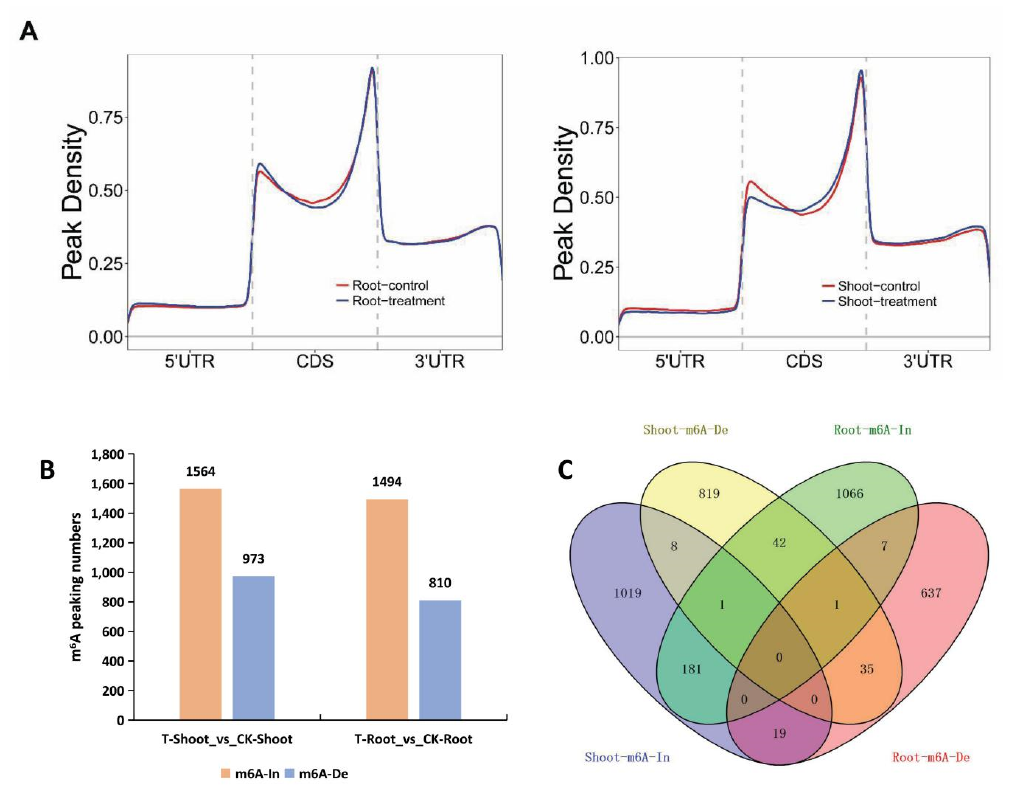
Figure 5. Changes in m 6 A peaks in response to salt stress. ( A ) Salt stress-induced m 6 A methylation changes in different gene regions (5′ UTR, CDS, and 3′ UTR) in the roots and shoots; ( B ) Number of genes with m 6 A methylations or demethylations in response to salt stress; ( C ) Venn diagram analysis of the genes with increased/decreased m 6 A levels (In-m 6 A/De-m 6 A) in the shoots and roots under salt stress conditions.